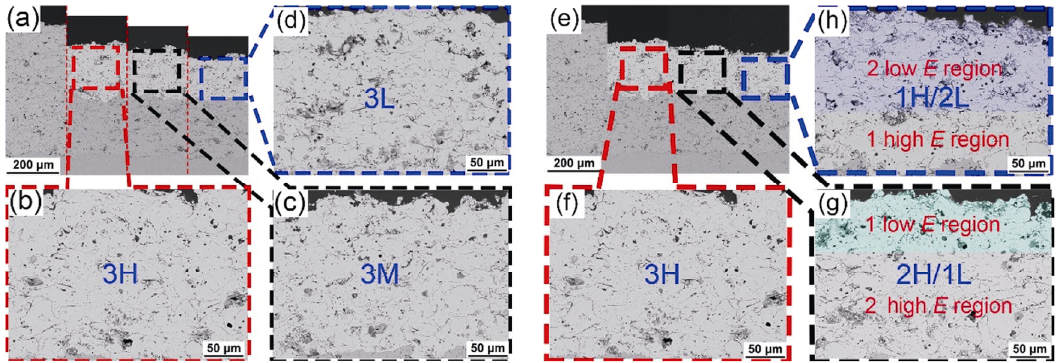
Fig. 60 Cross-sectional SEM images of long life span TBCs: (a–d) overall modulus reduction design and (e–h) sublayer structure design. Reproduced with permission from Ref. [353], © Elsevier B.V. 2019; Ref. [354], © Published by Elsevier Ltd. 2018.